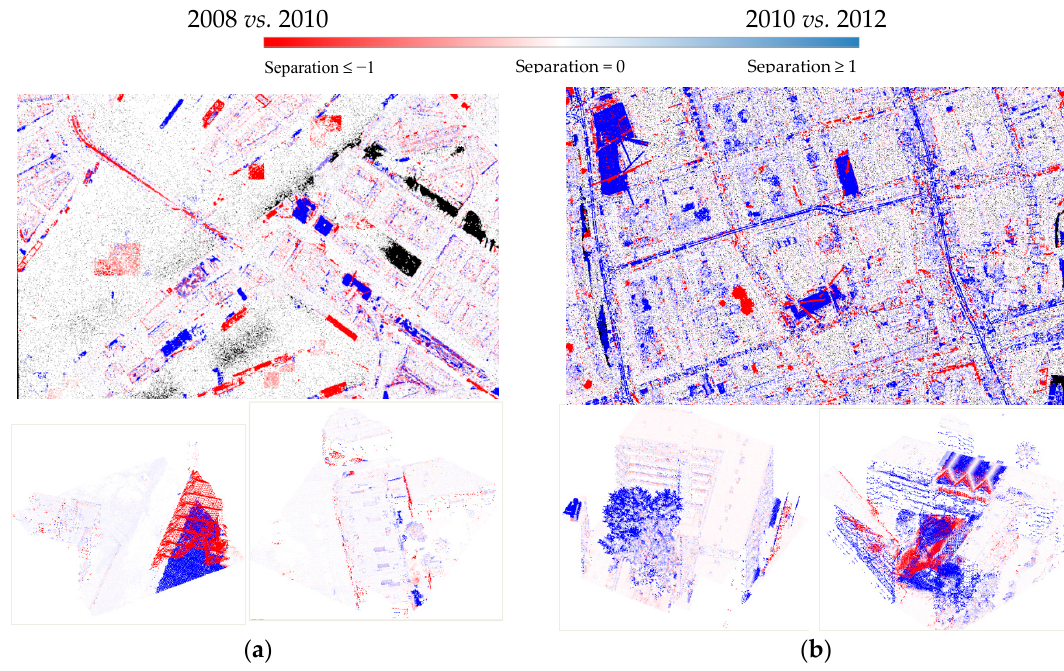
Figure 12. Surface difference maps for ( a ) 2008 vs. 2010 and ( b ) 2010 vs. 2012. Maps in the first column are the overall visualization of the test area, and maps in the second column are detailed visualization from some tiles.